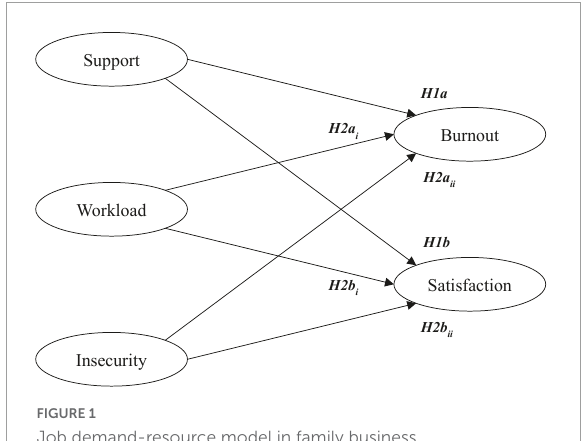
FIGURE1 Job demand-resource model in family